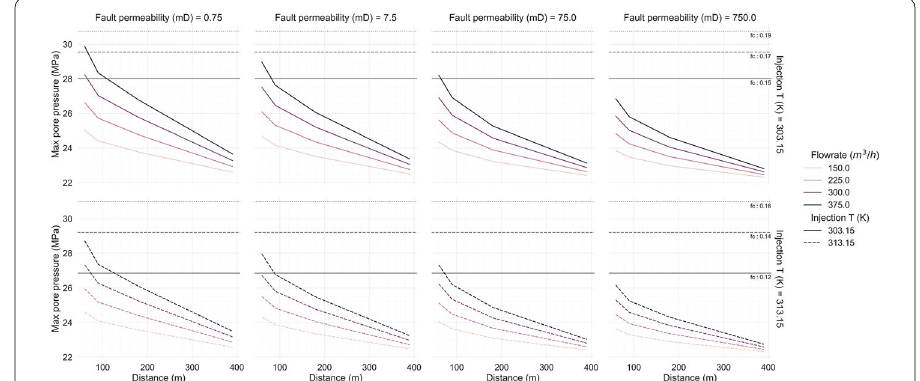
Fig. 12 Comparison of the maximum encountered pressure against fault to well distance for the range of flowrates, fault permeability and the highest and lowest injection temperature considered. The horizontal lines show the failure pressures as result of friction coefficients 0.15, 0.17, 0.19 and 0.12, 0.14, 0.16 for the injection temperature of 303.15 K and 313.15 K